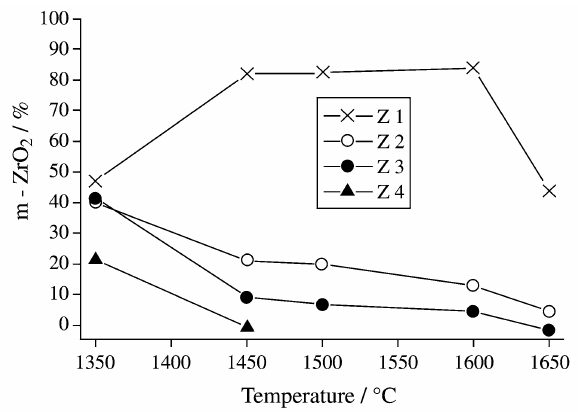
Figure 5. Evolution of the m-ZrO 2 with temperature and carbon content. (Reaction time: 120 min).